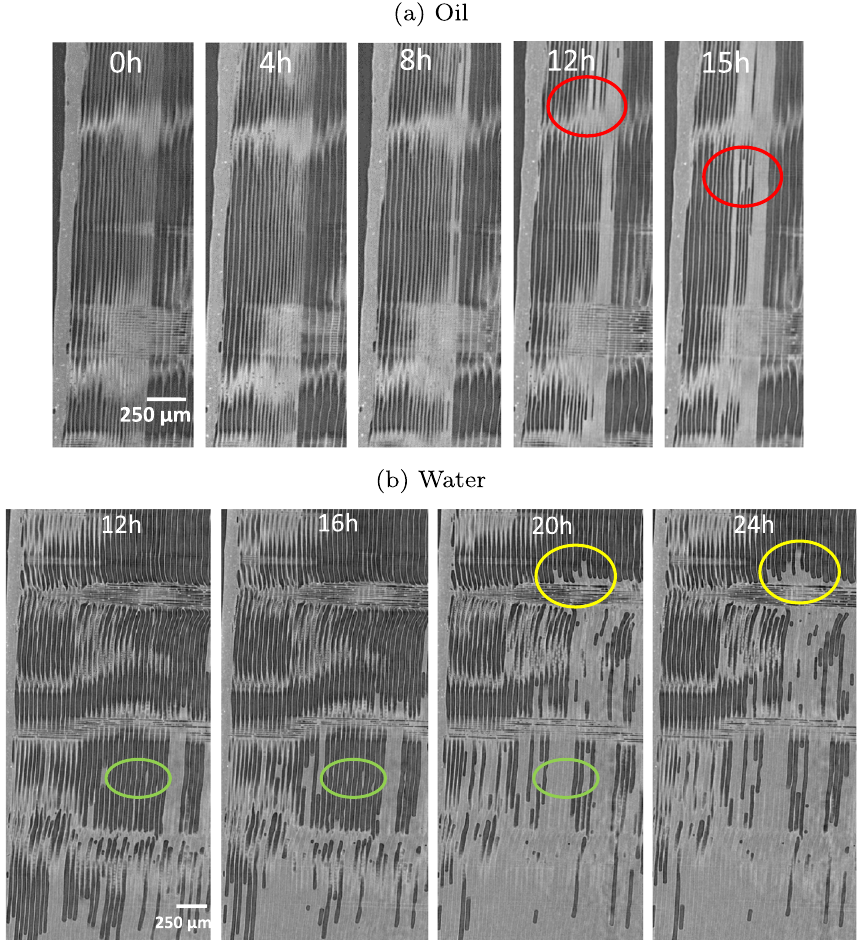
Figure 7. Imbition in spruce: micro-tomography TL sections at different times.